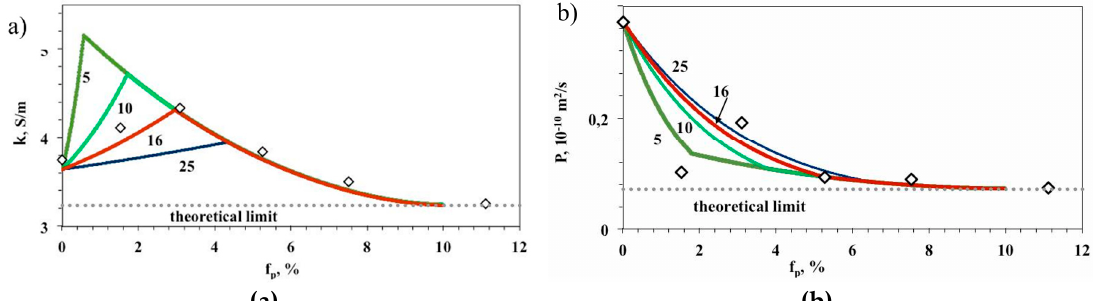
Figure 6. Proton conductivity in water κ ( a ) and diffusion permeability P (from 0.1 M HCl solution to water) ( b ) of a Nafion ® membrane doped with caesium acid salt of phosphotungstic heteropolyacid, as functions of nanoparticle volume fraction, f p . Diamond icons show experimental results [170]; the curves are calculated by applying the model [174] for different particle diameters shown in nm near the curves. The best fitting is obtained, when assuming that the nanoparticle size is 16 nm. Reproduced with permission from [174], Elsevier, 2016.